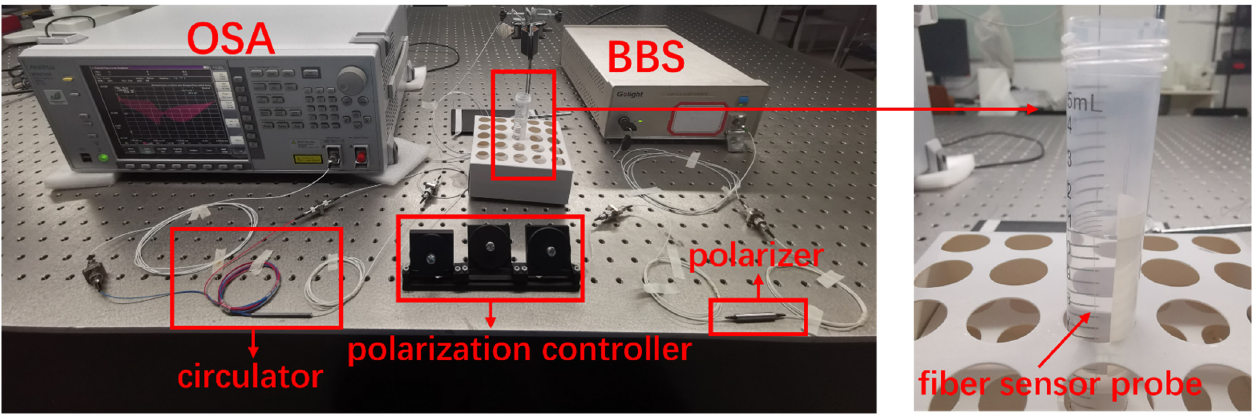
Figure 2. Real experimental set-up for SRI sensing.